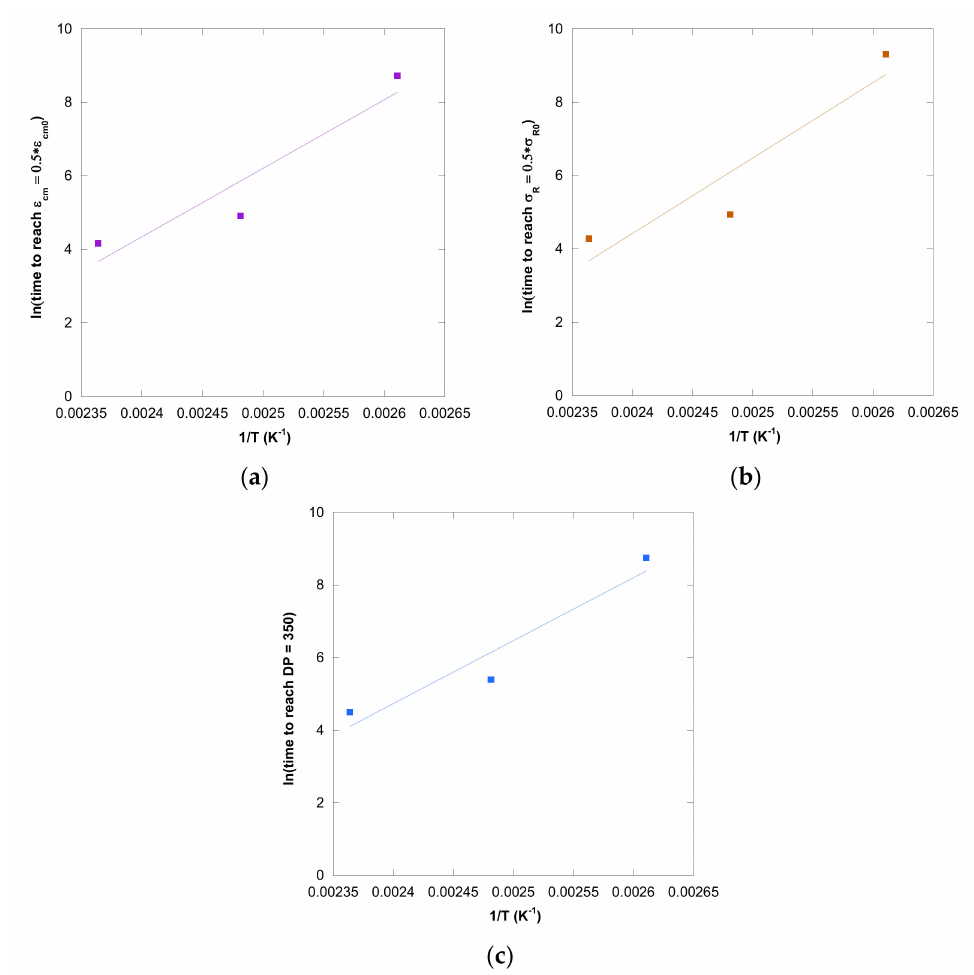
Figure 11. Evolution of the ln (time) vs. inverse temperature in CD for pressboard PSP 3055 aged in